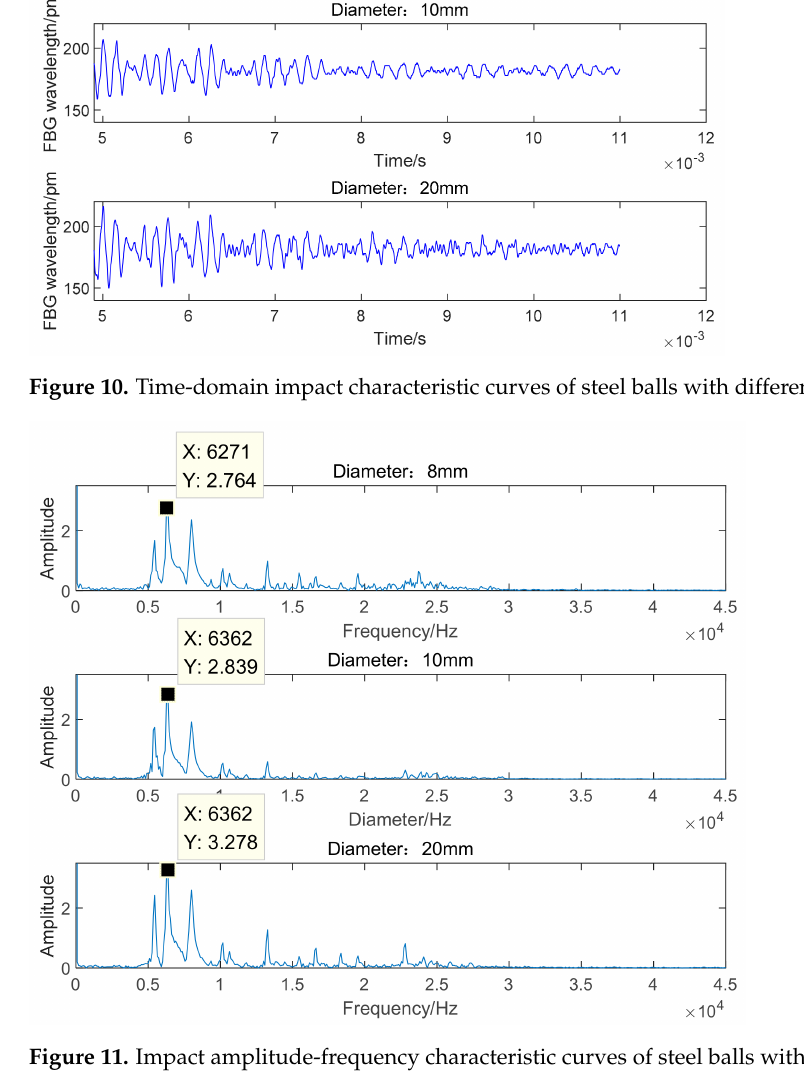
Figure 11. Impact amplitude-frequency characteristic curves of steel balls with different diameters. Perform power spectrum analysis on the experimental data, as shown in Figure